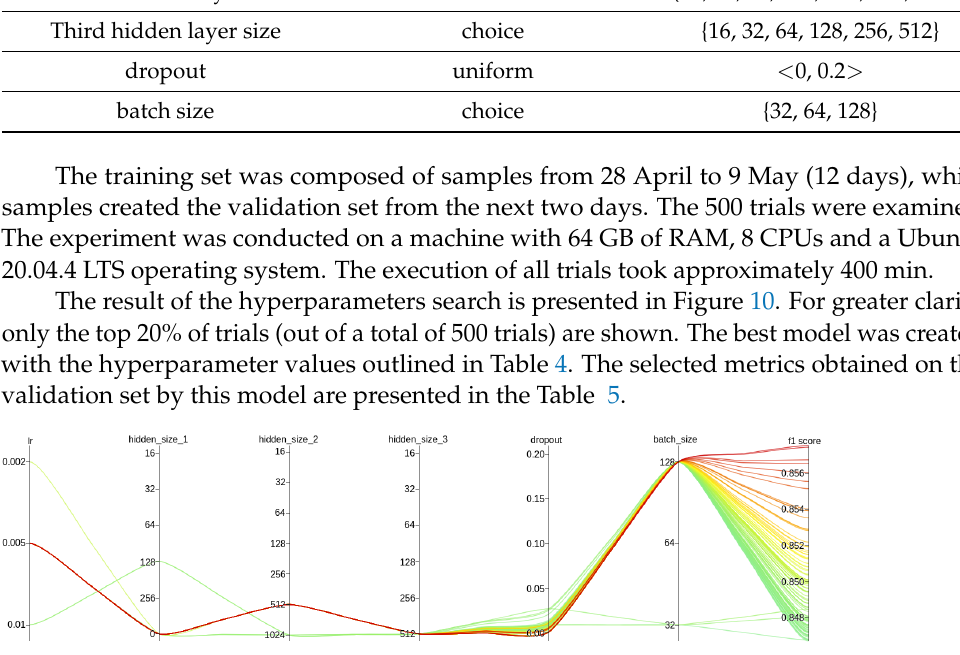
Figure 10. Top 20% trials of the hyperparameters